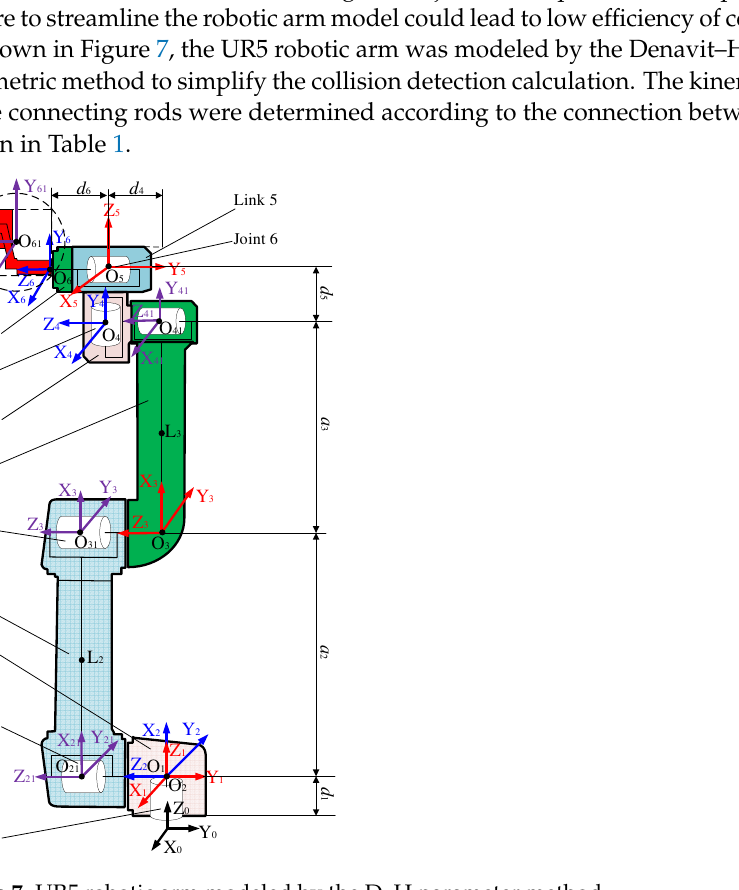
Figure 7. UR5 robotic arm modeled by the D–H parameter method. Table 1. D–H parameters.